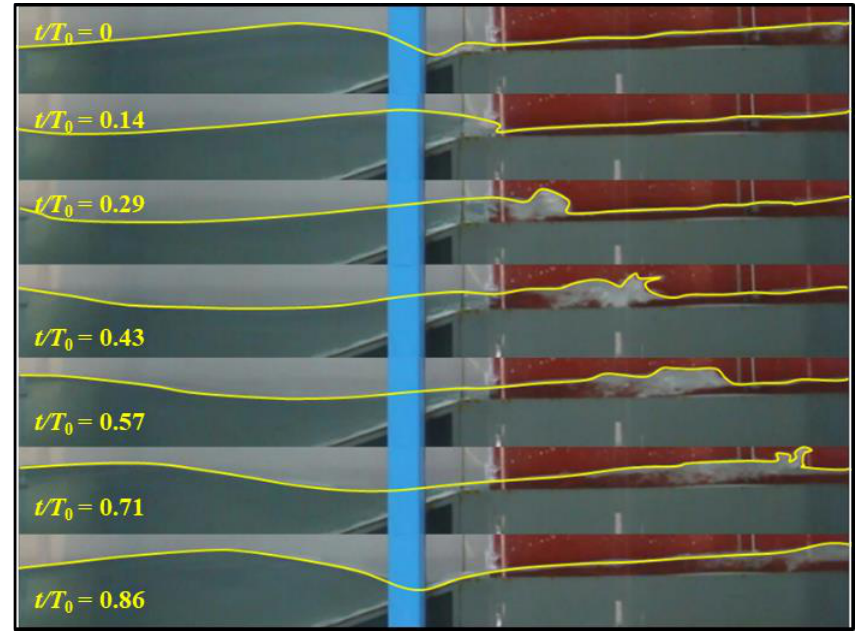
Figure 2. Wave propagation process on the reef flat for H 0 = 0.14 m, T 0 = 1.4 s, cot θ = 3, h r = 0.05 m.